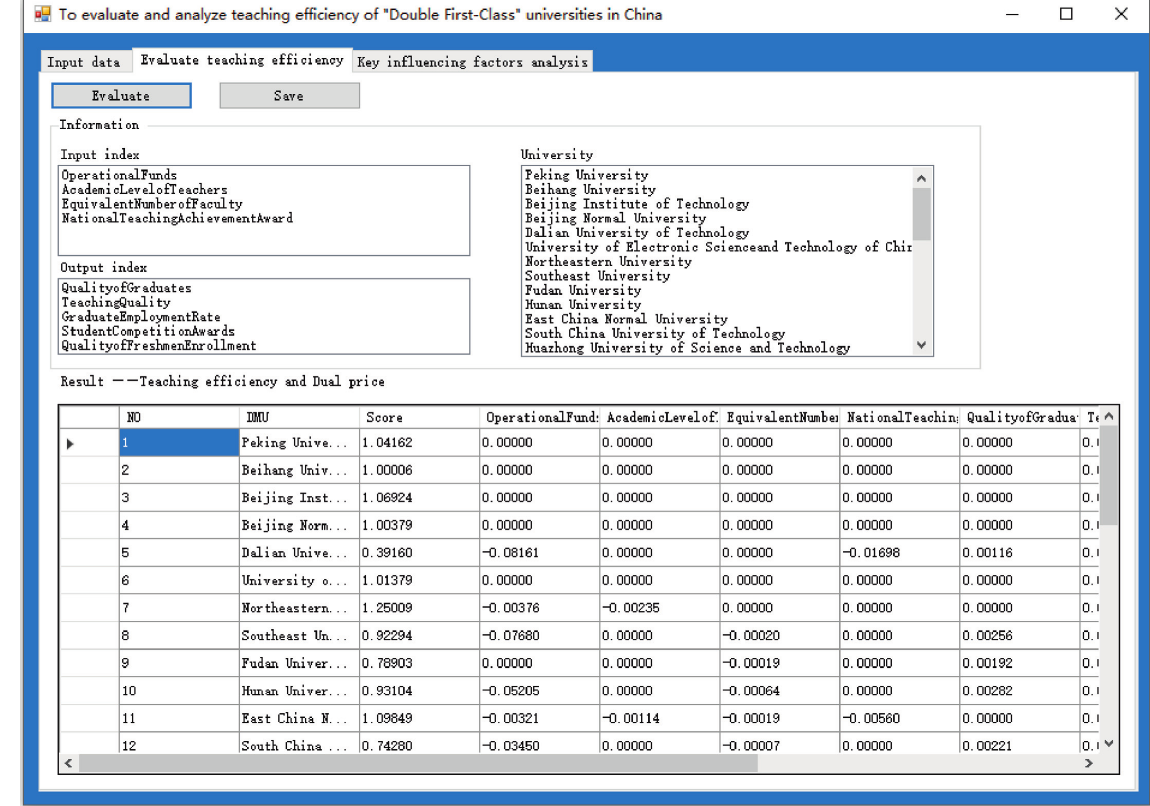
Figure 3: Interface for evaluating teaching